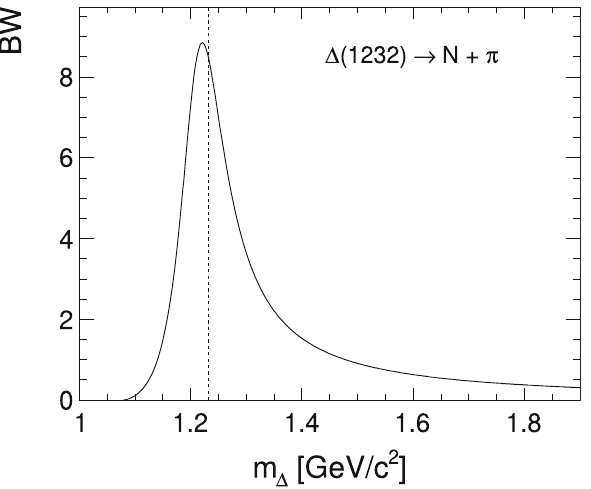
Fig. 159 BW mass spectrum of the Δ( 1232 ) resonance withfull width 118 MeV